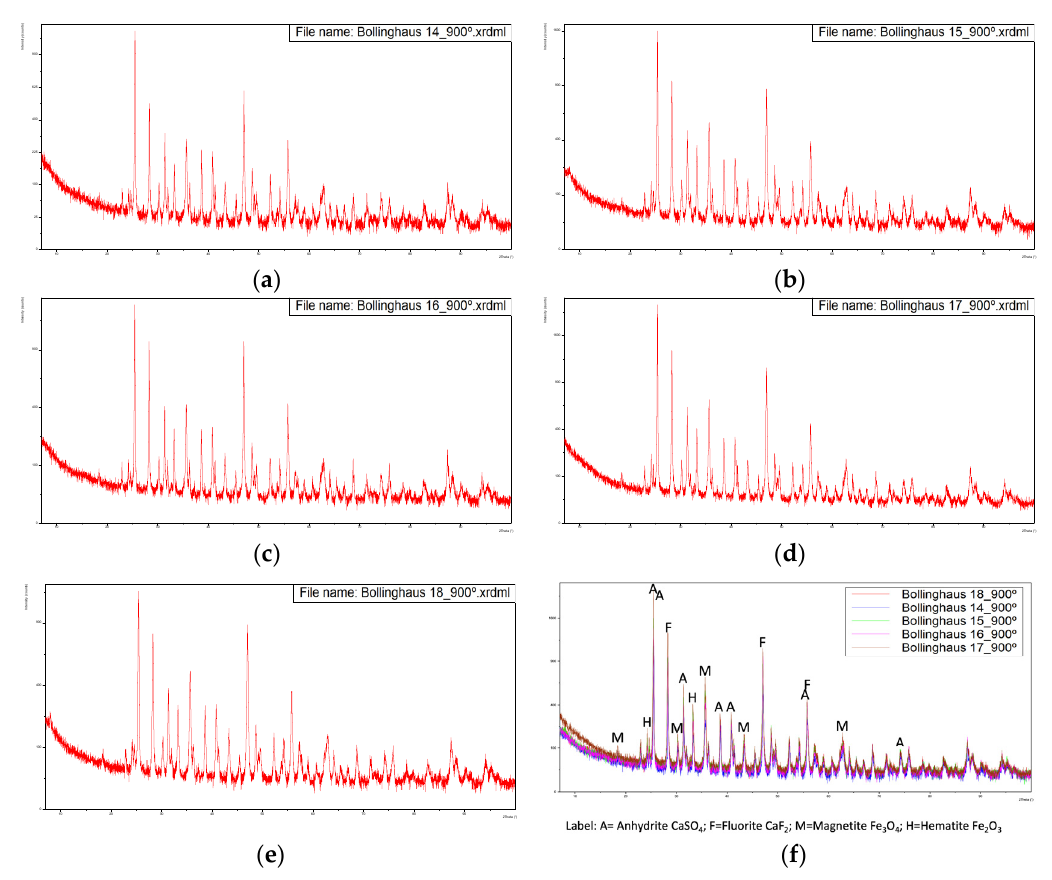
Figure 4. Diffractograms of the five samples calcined at 900 °C with overlapping of the same. ( a ) Sample from 14-02-2022, ( b ) Sample from 15-02-2022, ( c ) Sample from 16-02-2022, ( d ) Sample from 17-02-2022, ( e ) Sample from 18-02-2022, ( f ) Overlapping of the previous diffractograms with identification of the main peaks. The Rietveld refinement of the diffractograms allowed us to estimate the compound compositions indicated in Table 4. Table 4. Estimated compound compositions of the samples calcined at 900 °C obtained by the Rietveld refinement method. Compound